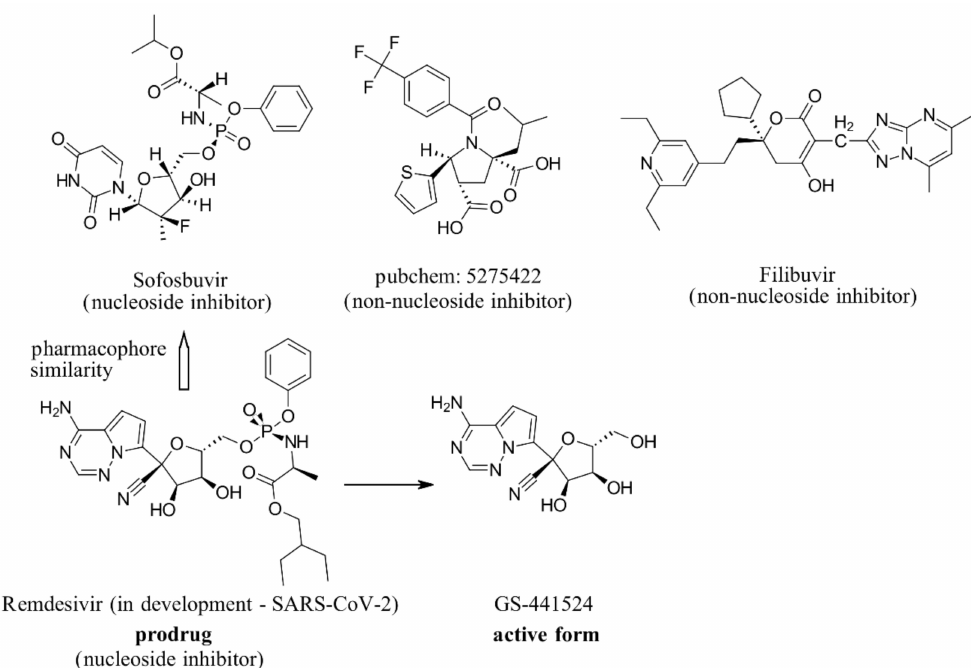
Figure 2. Some of the existing nucleoside and non-nucleoside inhibitors of RdRps found in the scientific literature primarily developed against